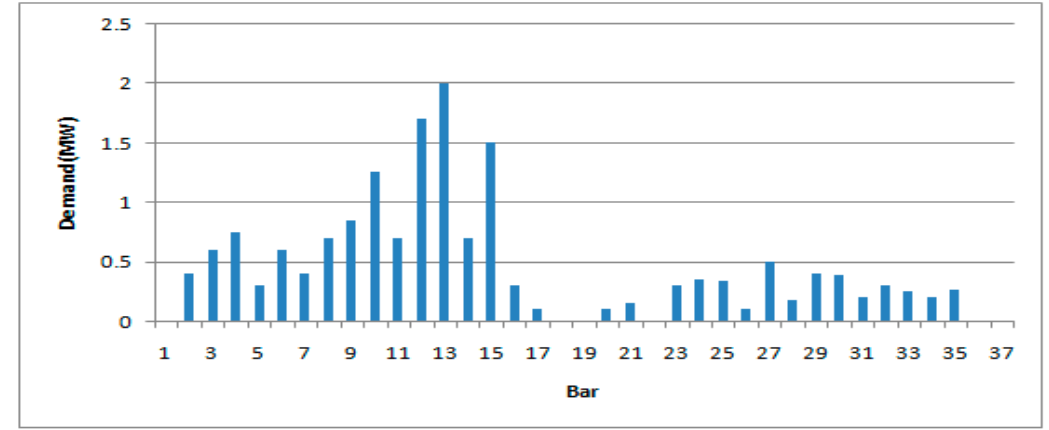
Figure 3. Distribution of demand in the system of 34 bars.